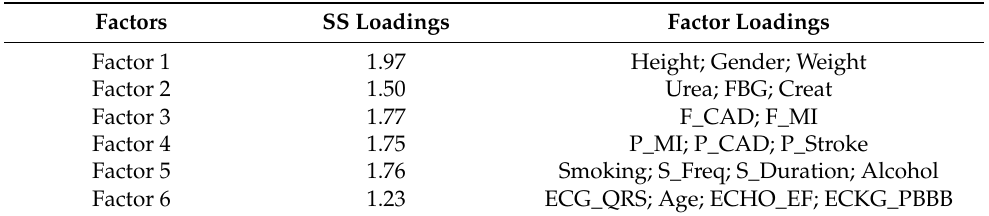
Table 7. SS loading values with factor loadings for the six-factors FA model with rotation Oblimin.